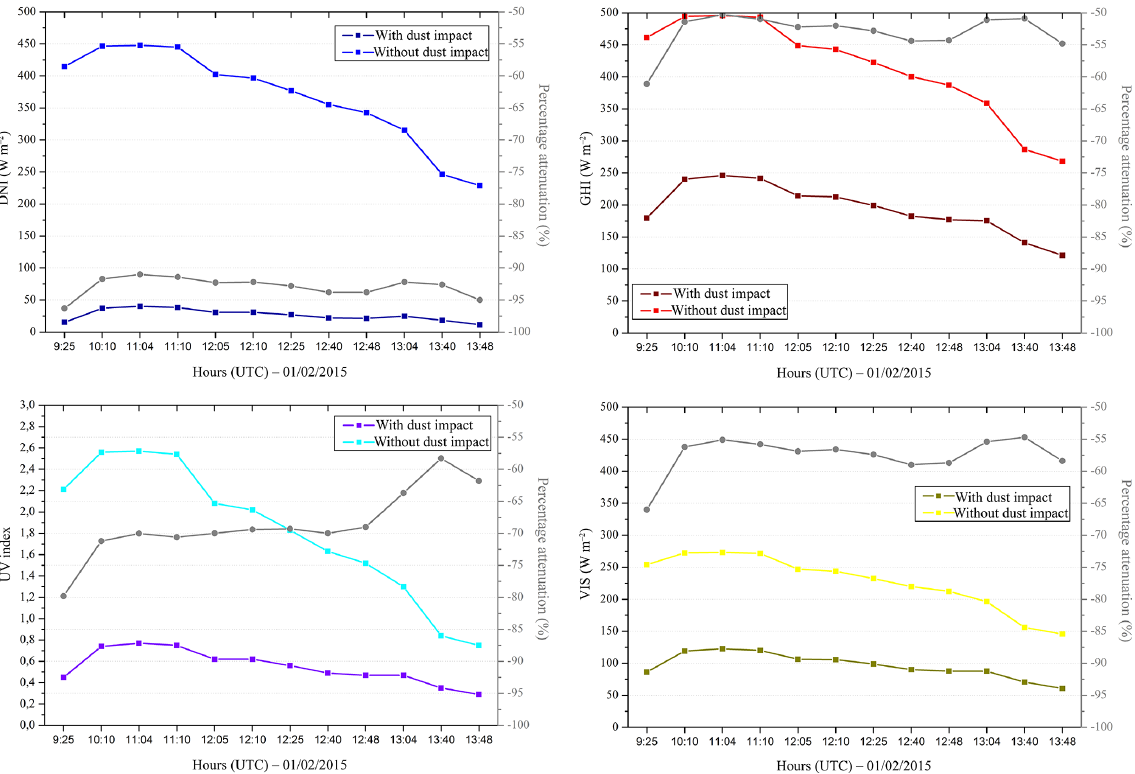
Figure 8. Temporal evolution of GHI, DNI, UV index and VIS irradiances during the extreme dust event of 1 February 2015 at the Athens station. The modelled values (without dust impact) coincident with AERONET Cimel measurements (with dust impact) are shown together with the % attenuation due to the impact of dust.